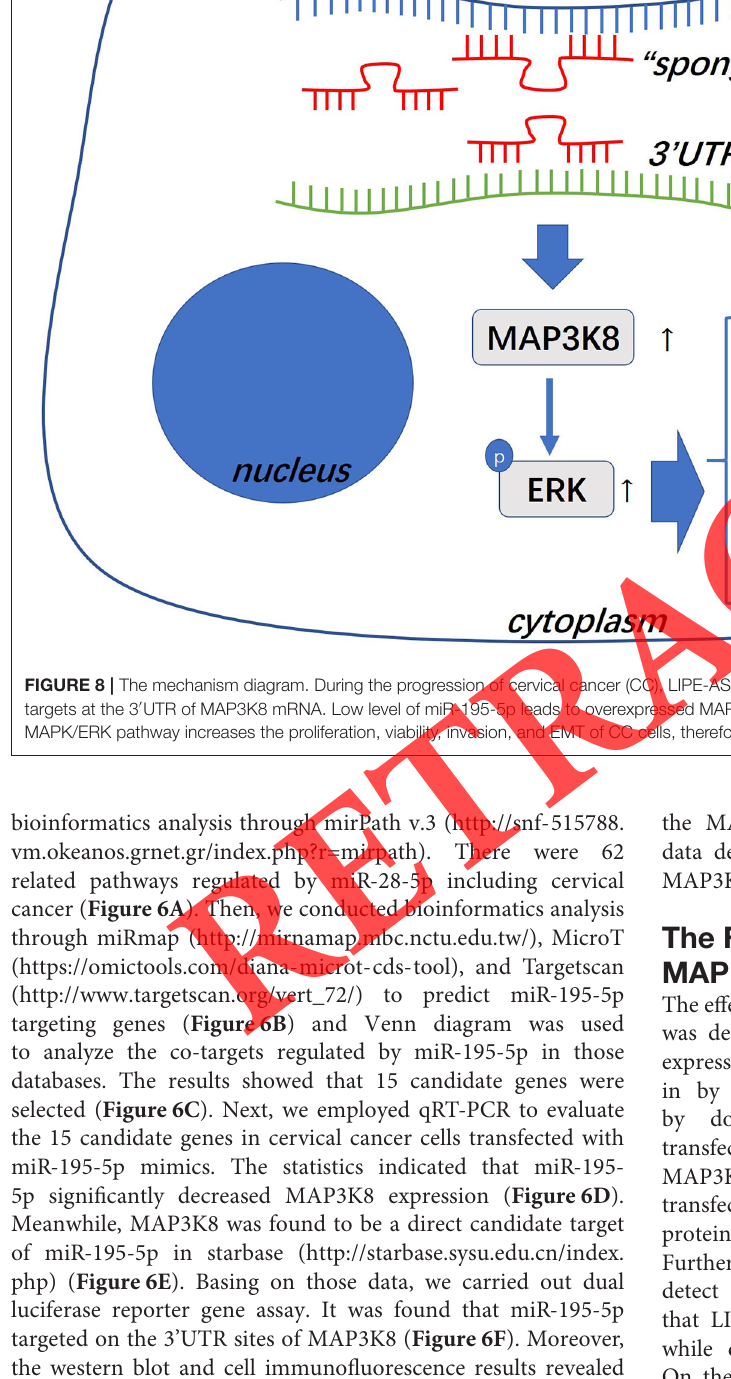
bioinformatics analysis through mirPath v.3 (http://snf-515788. vm.okeanos.grnet.gr/index.php?r=mirpath). There were